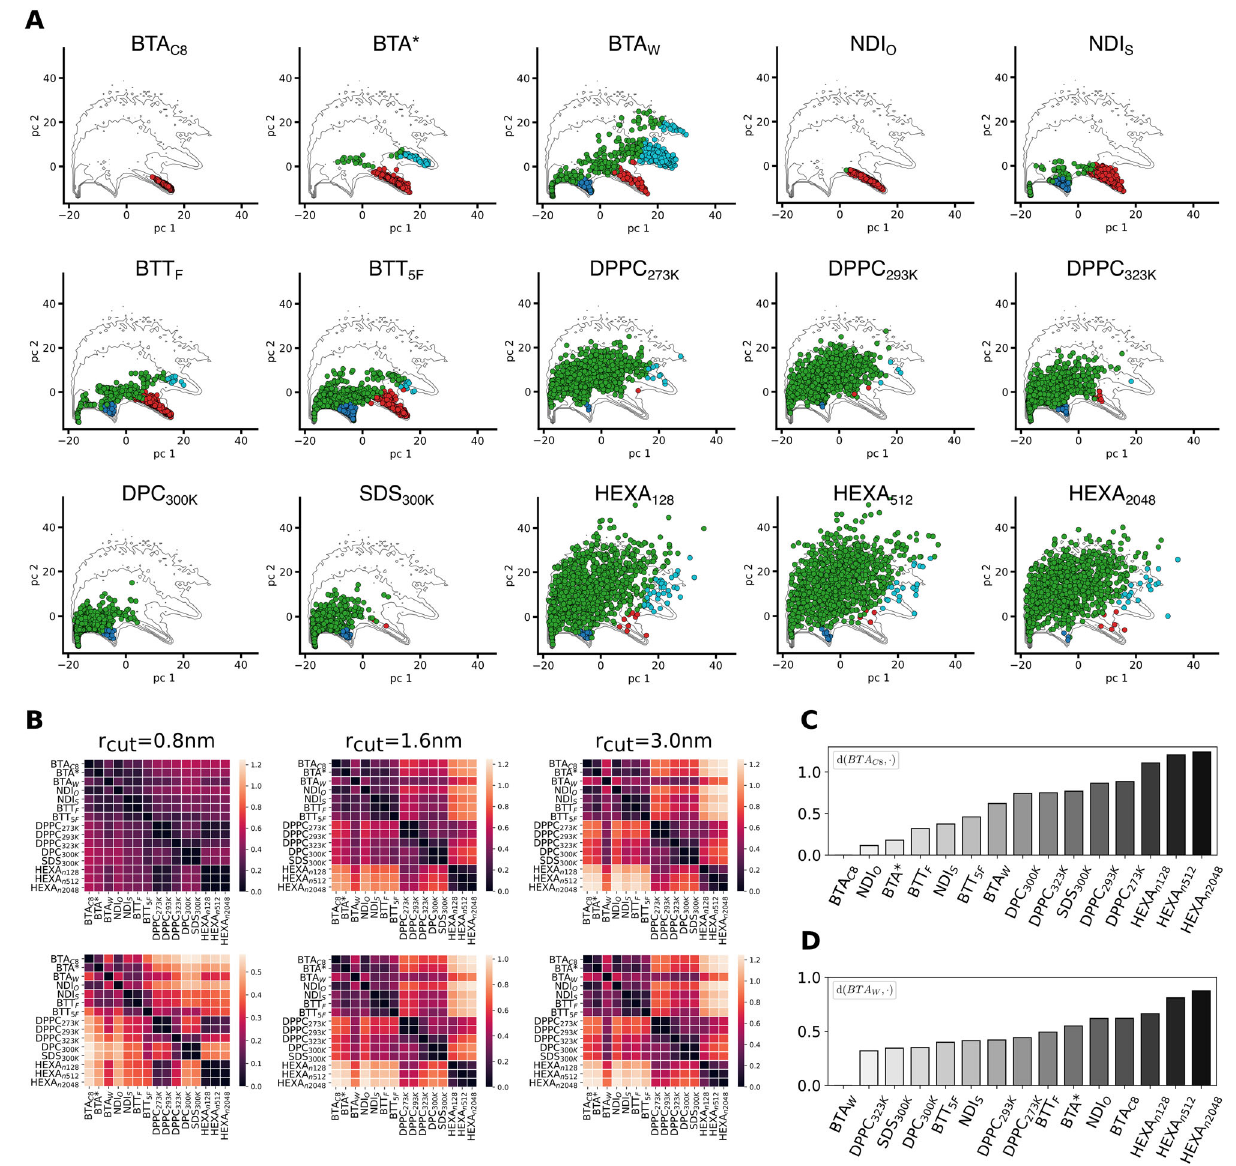
Fig. 6 Comparison of different types of soft dynamic supramolecular materials. A SOAP + PAMM analysis for all the 15 systems considered in the present work. Each panel reports the PCA scatter plot of SOAP feature vectors relative to a single system projected onto the global SOAP vector dataset (accounting for all considered systems: black contour plot). The colors indicate the molecular motifs detected by the PAMM clustering algorithm. The reported data are obtained using rcut = 0.8 nm in the SOAP analysis (same as in Figs. 1 – 3). Analogous plots, obtained using larger rcut values ( rcut = 1.6 and rcut = 3.0 nm) are shown in Supplementary Figs. 6, 7. B Distance d SOAP matrices, computed from the SOAP simulation -averages using different cutoffs in the SOAP analysis (left: rcut = 0.8 nm, center: rcut = 1.6 nm, right: rcut = 3.0 nm); each matrix is reported twice, using a fi xed d SOAP scale (top: 0.0 < d SOAP < 1.25), or a d SOAP scale that is adapted for each case (showing consistent similarity results at all rcut values). C Plot of d SOAP between BTA C 8 (reference) and all the other assemblies (reported data computed with rcut = 3.0 nm). D Same as ( C ) but setting BTA W as the